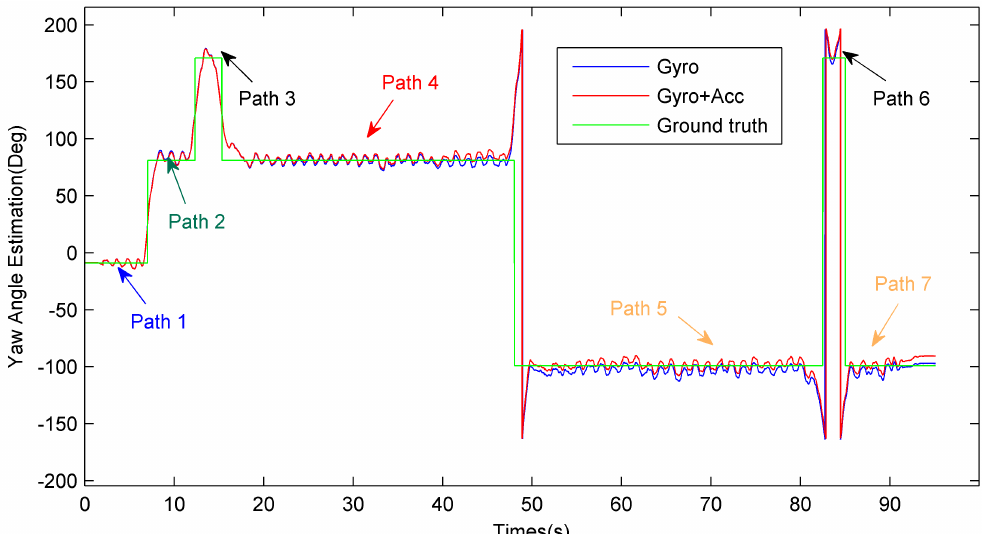
Figure 5. True path in the experimental environment.